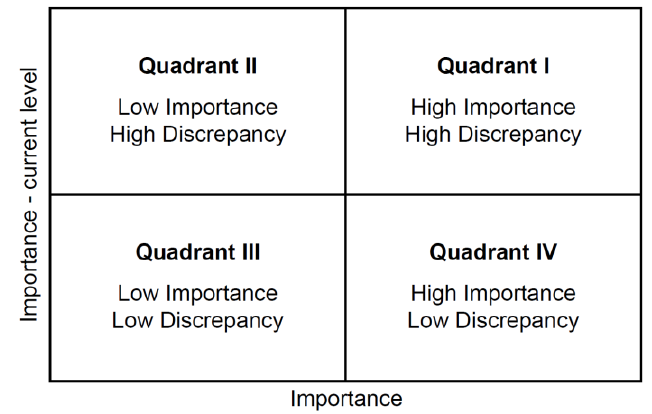
Figure 1. The Locus for Focus Model. 176